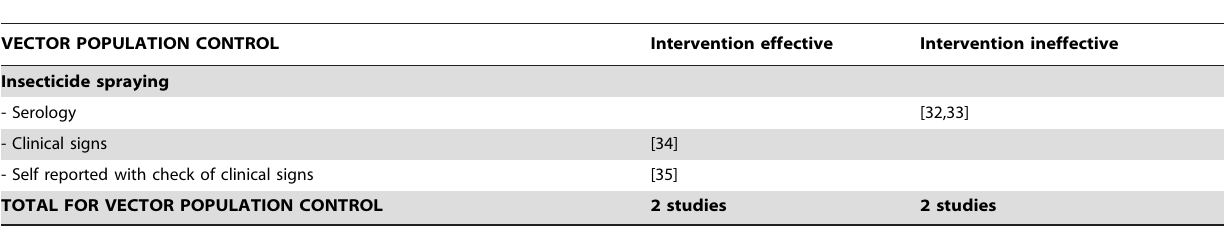
Table 2. Summary table of human outcome measurements for vector population control interventions.